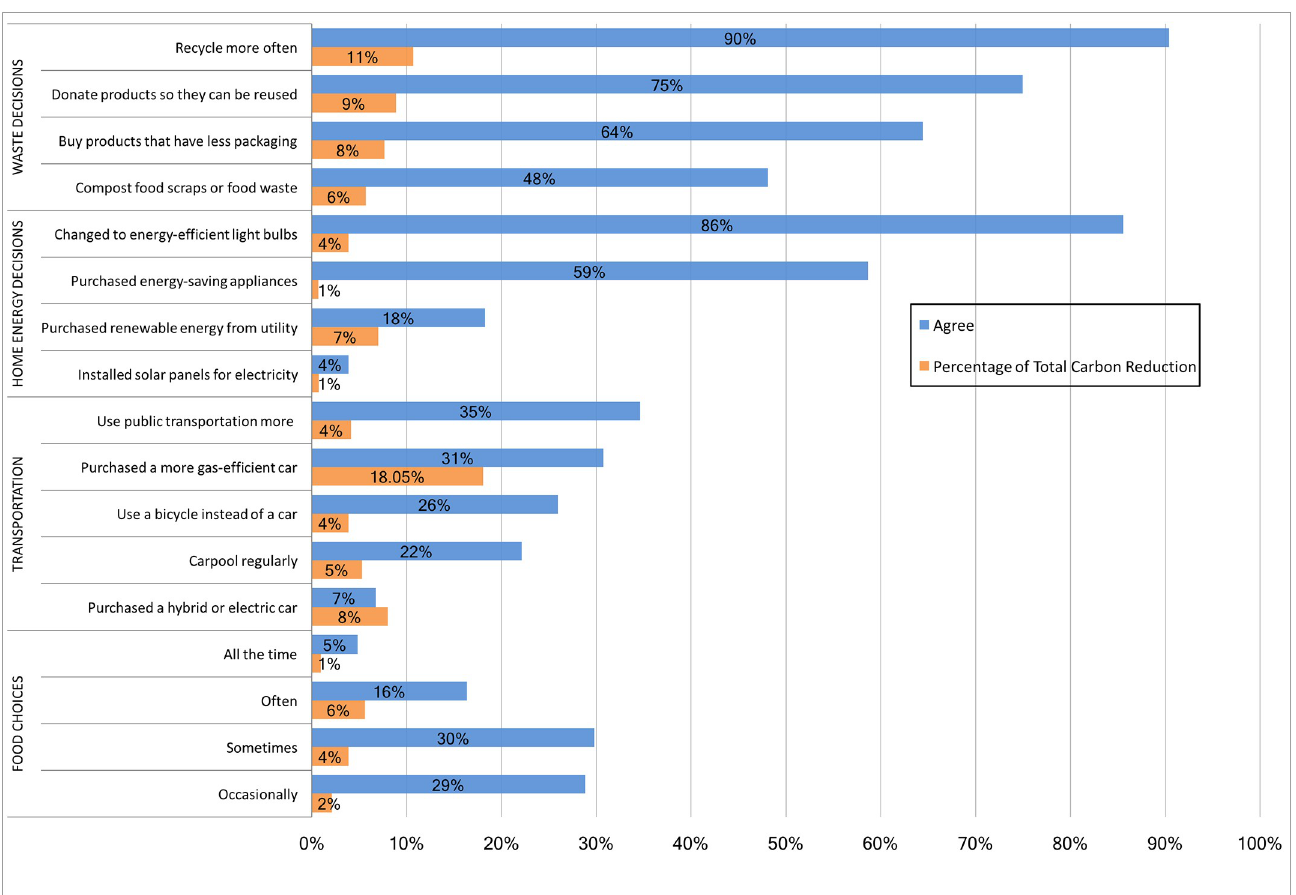
Fig 2. Survey results for questions related to how often participants make choices to reduce carbon emissions as a result of the COMM 168 course. The blue bars represent the percentage of students who agreed with the survey response, while the orange bars represent the impact in carbon emissions in percent relative to the total